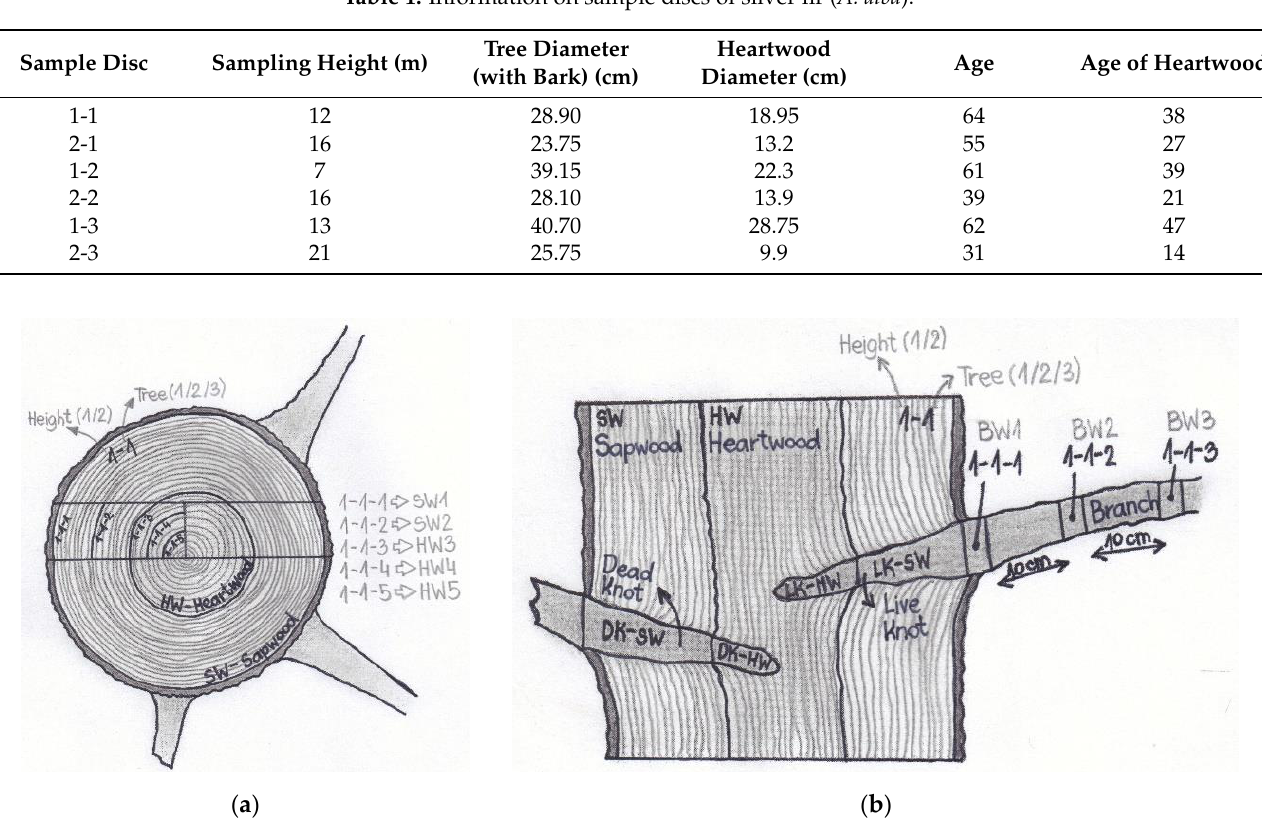
Figure 1. Simple scheme showing the sampling sites for stemwood samples ( a ), and for knotwood and branchwood samples ( b ) of silver fir ( A. alba ).